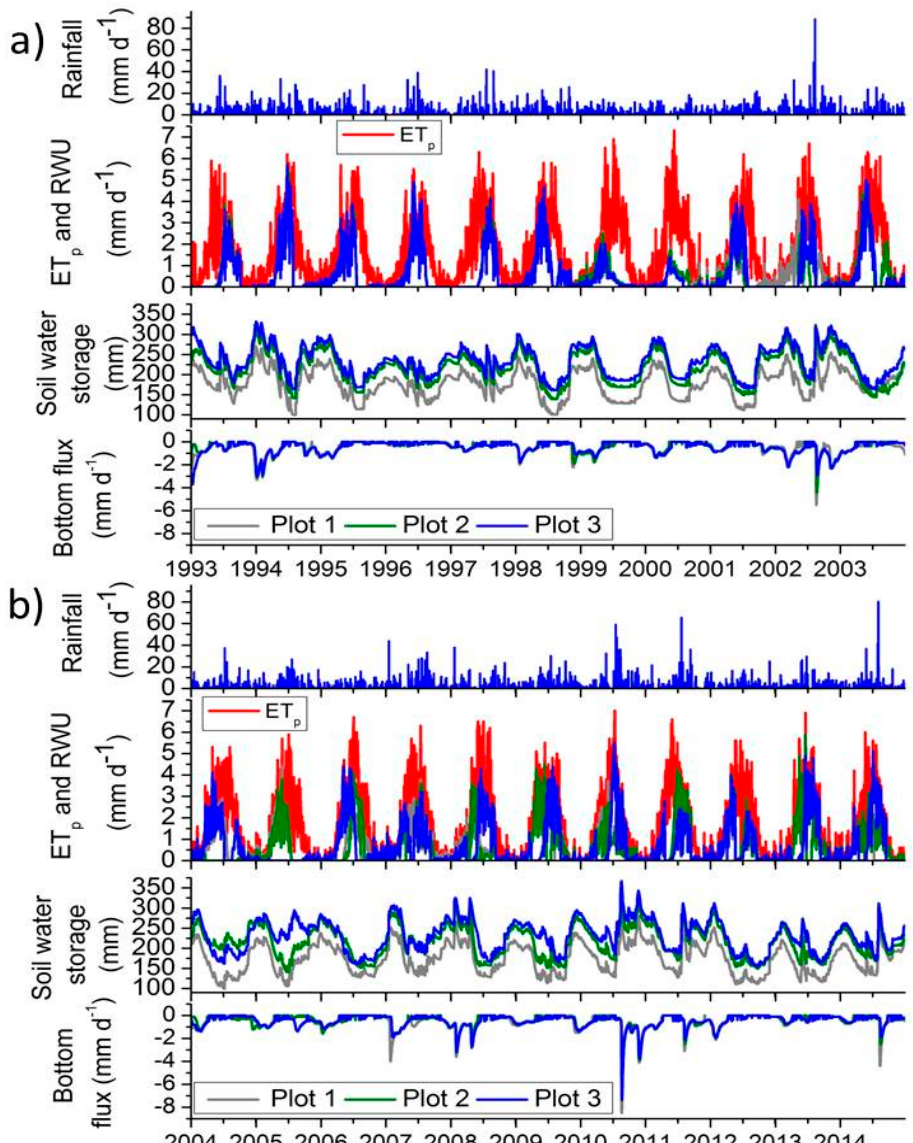
Figure 4. Daily rainfall, simulated ET p and actual root water uptake (RWU), soil water storage 0–200 cm depth and bottom flux at 200 cm depth, Plot 1–3: ( a ) 1993–2004; ( b ) 2004–2014.